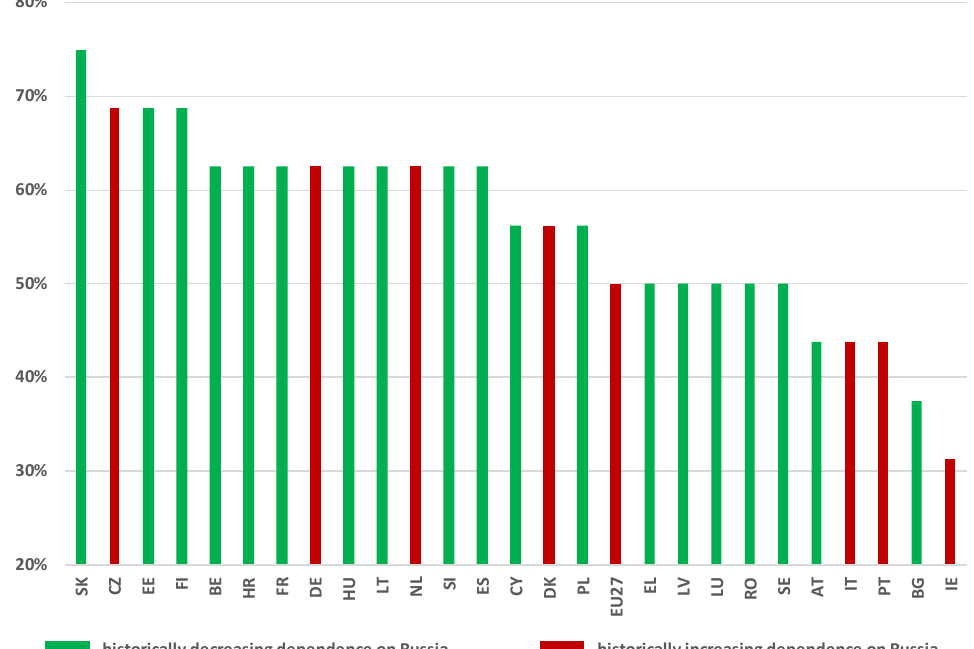
Figure 3. Consistency of DRs versus DRT per country.